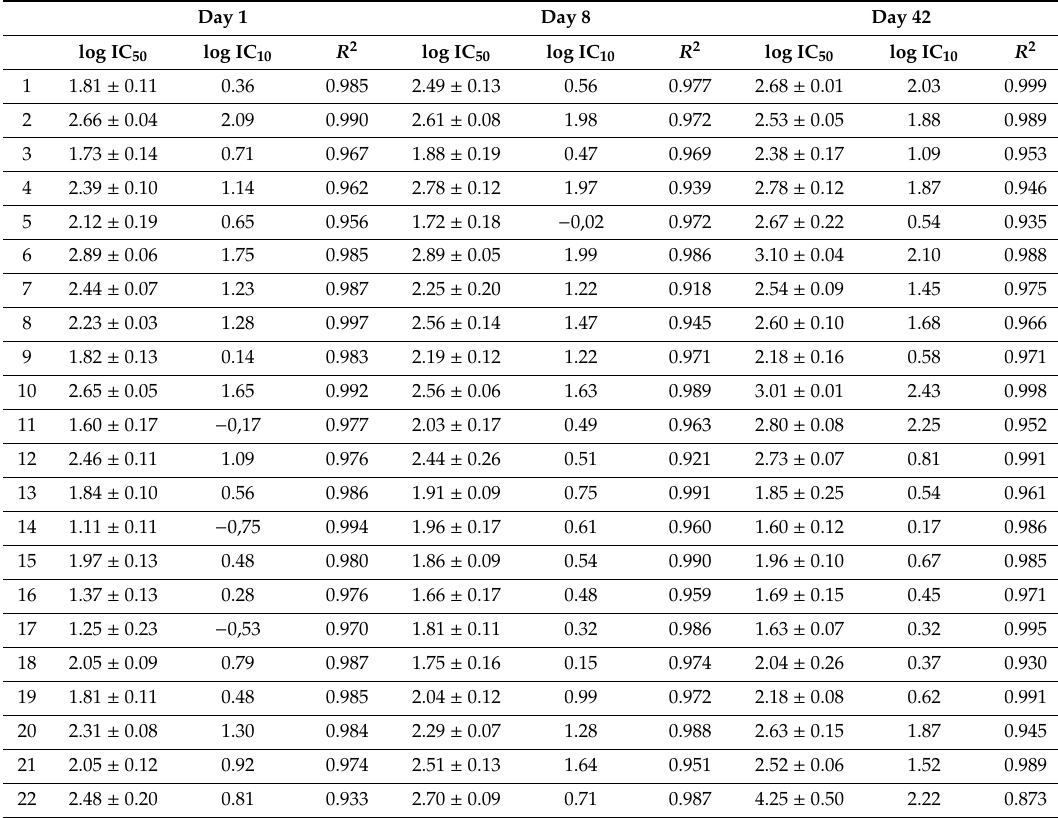
Table 2. Chlortetracycline toxicity on soil bacterial community growth estimated as log IC 10 and log IC 50 values (mean ± standard error, n = 3) after 1, 8, and 42 incubation days. R 2 values represent the coe ffi cients of determination for the logistic